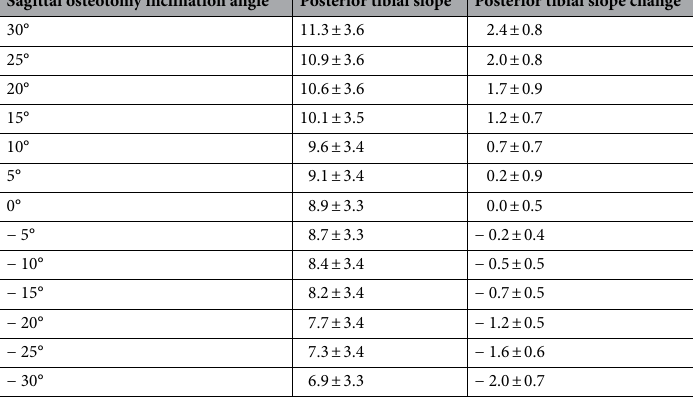
Table 2. Postoperative posterior tibial slopes measured on the 3D models where the virtual osteotomy was performed with various sagittal osteotomy inclination angle. The values are presented as mean ± standard deviation.